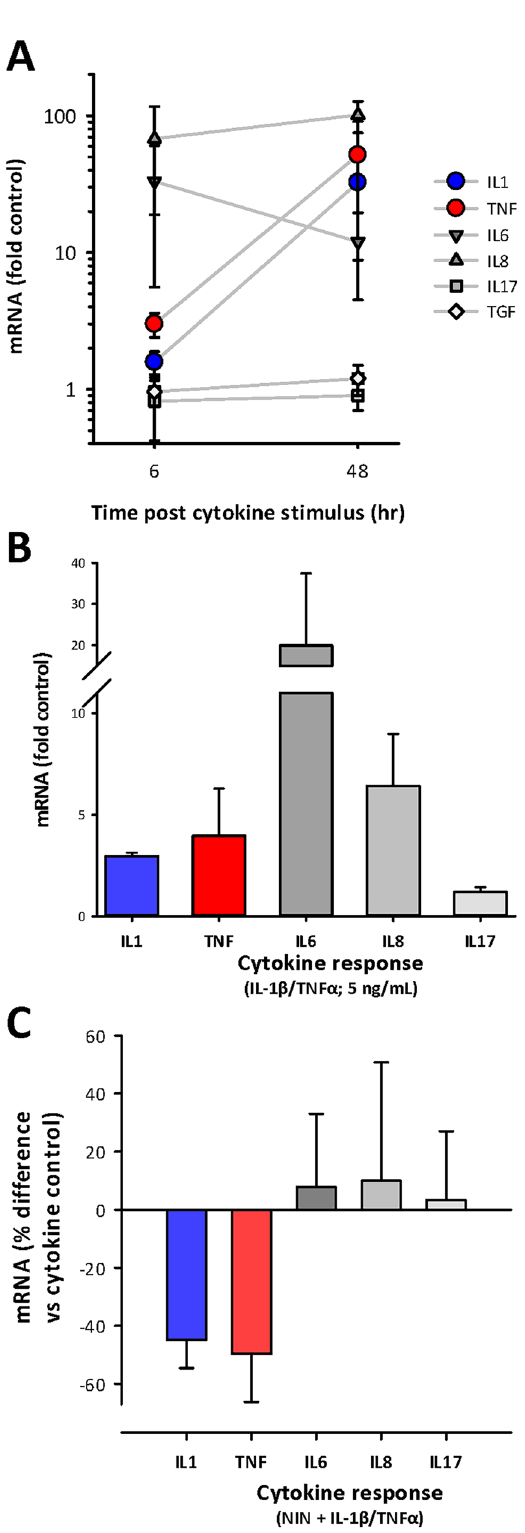
Figure 6. NIN regulates cytokine-induced cytokine expression in CSMC. CSMC were stimulated with the pro- inflammatory cytokines IL-1β and TNFα (50 or 5 ng/mL each) and cytokine expression determined by qPCR at 6 or 48 h. ( A ) Increased expression of the pro-inflammatory cytokines IL-1β, TNFα, IL6 and IL8 but not IL17 or TGFβ at 6 and 48 h. Note large further increases in IL-1β and TNFα between 6 and 48 h. ( B ) Reduced level of stimulation IL-1β/TNFα (5 ng/mL each; 6 h exposure) maintains significant stimulation of IL-1β, TNFα, IL6 and IL8 but not IL17. ( C ) NIN (1 µM) reduces cytokine-induced expression of IL-1β and TNFα, but does not affect IL6, IL8 or IL17. Data expressed relative to cytokine-stimulated control (n = 4 cell lines), with stimulus of TNFα and IL-1β at 5 ng/mL for 6 h. Data, all p < 0.05 vs respective